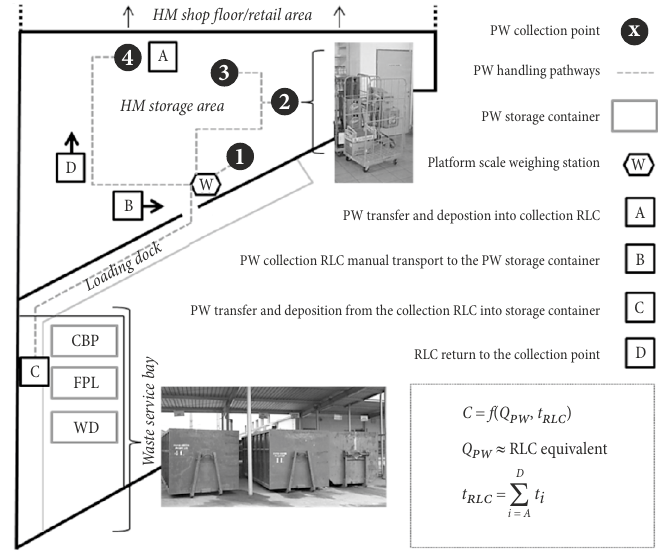
Figure 7. Selected HM’s PW handling process layout with general cost